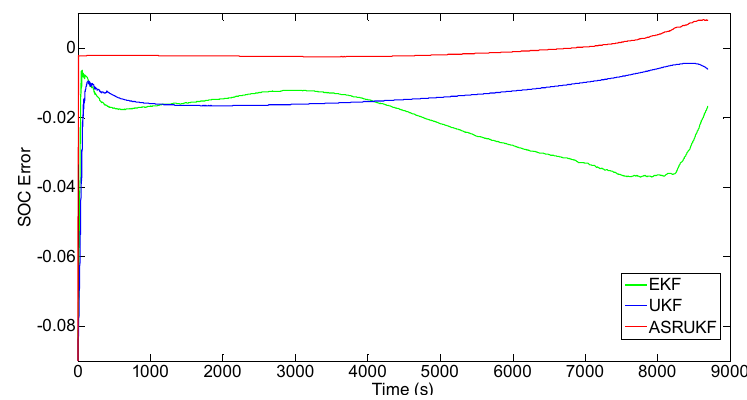
Figure 12. EKF, UKF, and ASRUKF SOC estimation error in the UDDS test.